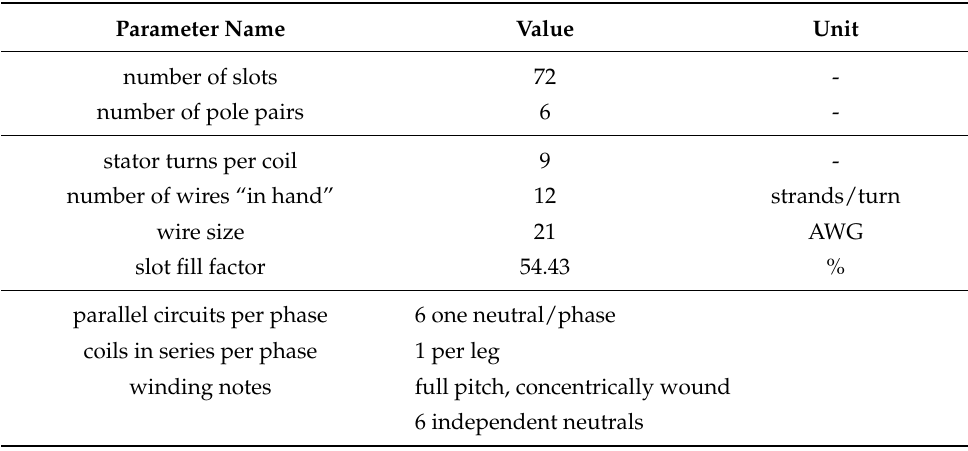
Table A2. Parameters of the machine